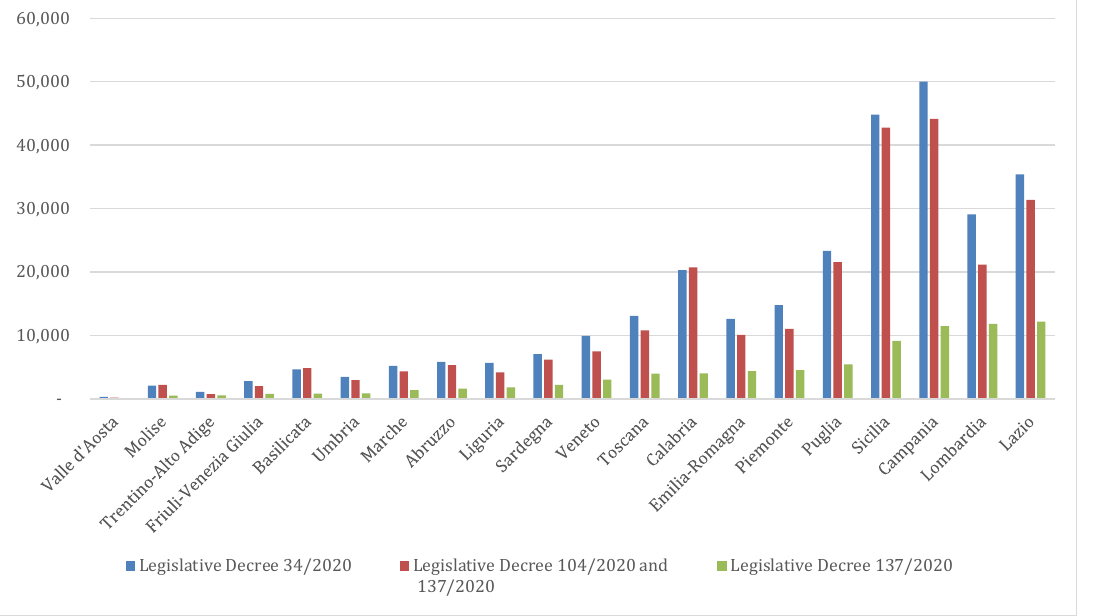
Figure 18. REM recipients, by household composition, 2021. Source: own elaboration on the INPS database. The Emergency Income reached the population of youngsters, with more than one minor, tendentially larger than those covered by RdC. REM covered more households with employed workers and foreign citizens whilst the territorial distribution is mainly focused on the northern regions of Italy (INAPP 2020).